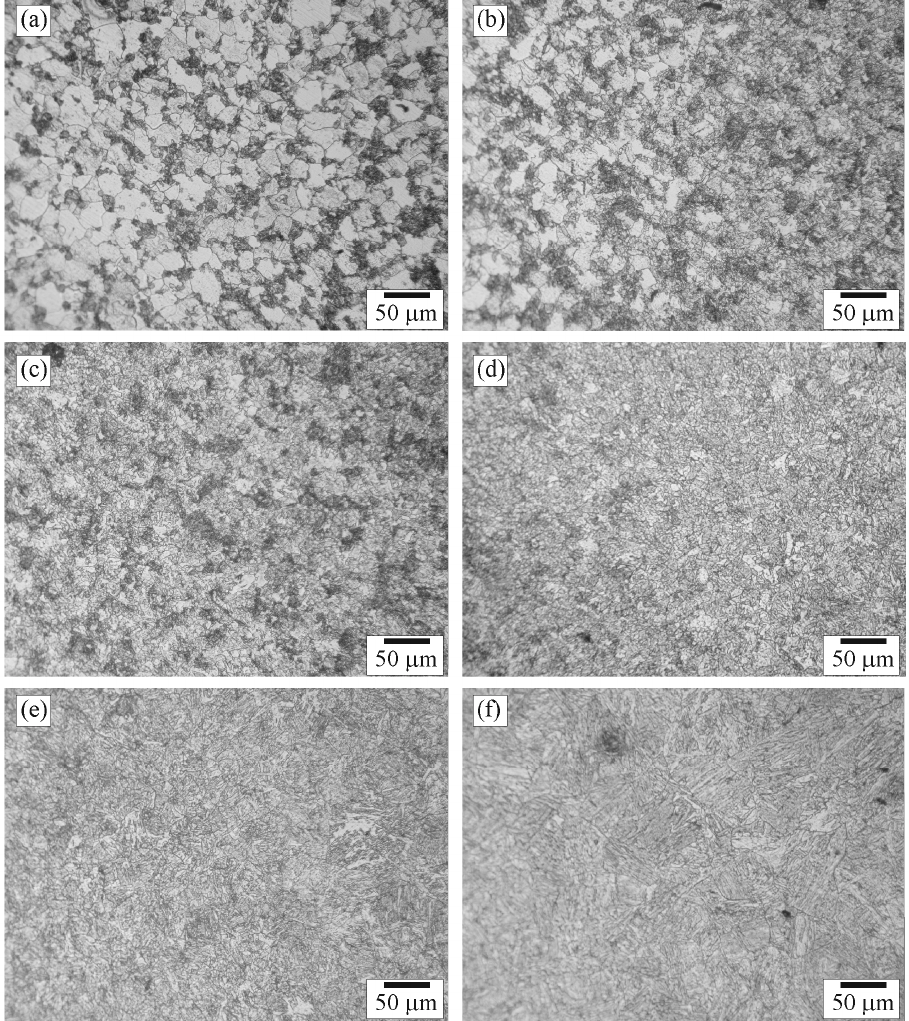
Figure 5. Optical micrographs of positions: ( a ) Ba; ( b ) Bb; ( c ) Bc; ( d ) Bd; ( e ) Be; and ( f ) Bf in Zone B. Microstructures of Zone C selected for examination were those of positions Ca (close to B–C zone interface), Cc (close to the 4th pass joint), Cb (etween positions Ca and Cc), Cd (close to C–D zone interface), and Ce (in the middle of Zone C). The microstructures of positions Ca–Ce are shown